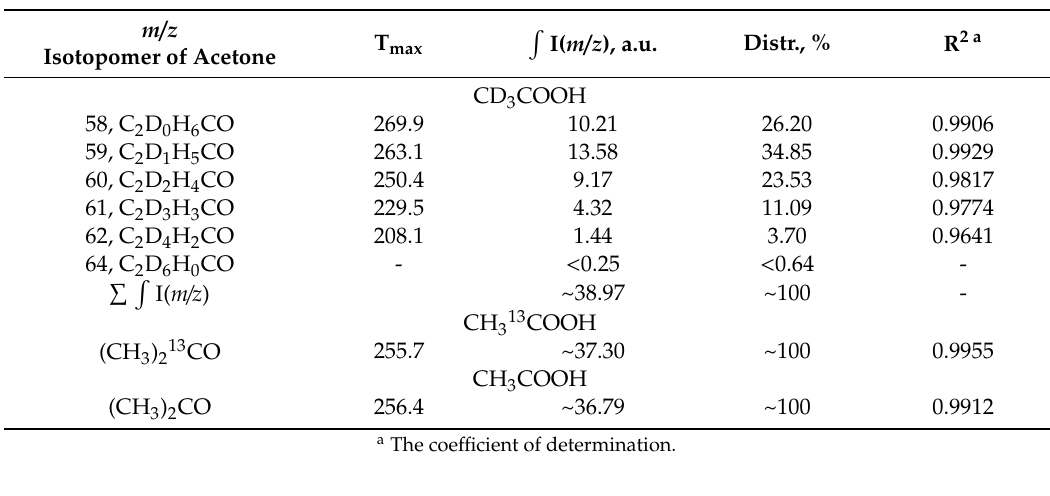
Table 3. Temperature of the maximum desorption rate T max , integral intensity (∫ I( m/z )) and distribution (%) of acetone isotopomers with m/z = 64, 62, 61, 60, 59, 58 obtained during the catalytic pyrolysis of isotopic-labeled acetic acid CD 3 COOH, CH 313 COOH and nonlabeled acetic acid CH 3 COOH on the hCeSi surface (0.6 mmol∙g −1 ).